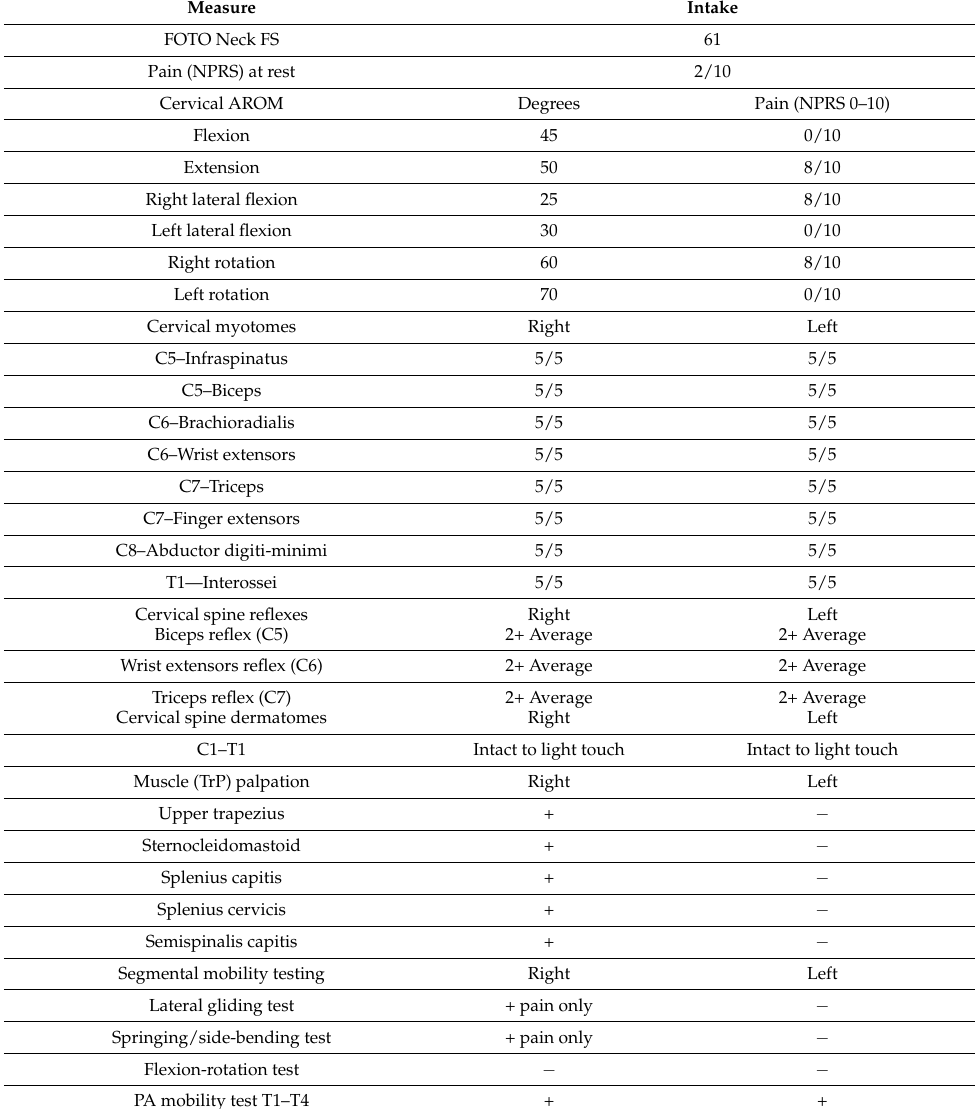
Table 1. Findings on initial